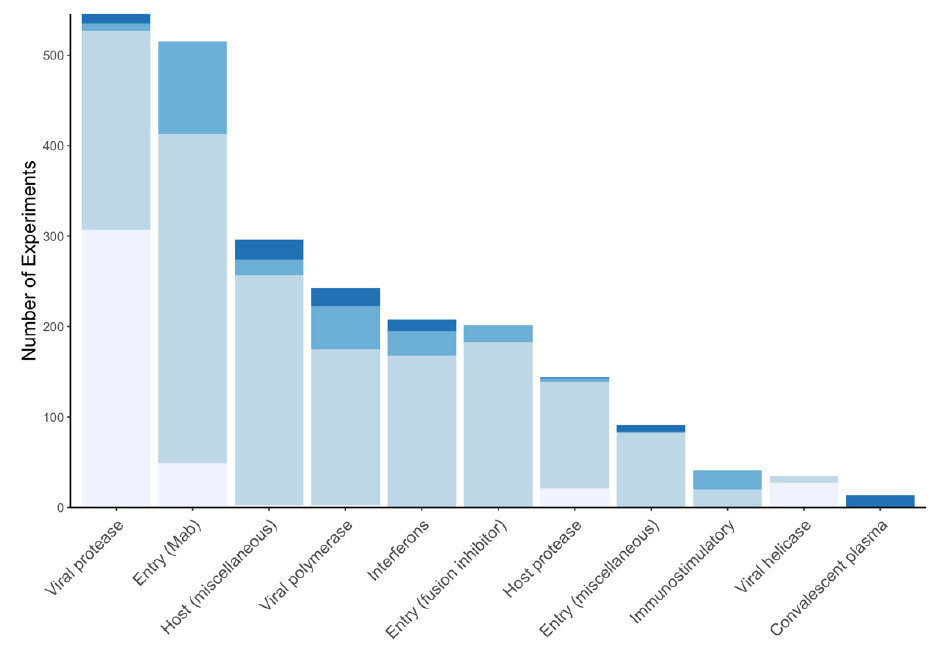
Figure 3. The distribution of biochemical experiments (lightest), cell culture experiments (light), animal model studies (dark), and clinical studies (darkest) for the different targets of antiviral therapy in the Coronavirus Antiviral Research Database (CoV-RDB). The cell culture experiments also include entry assay experiments. The results for approximately 600 experiments involving compounds with an unknown or uncertain mechanism of action are not shown.